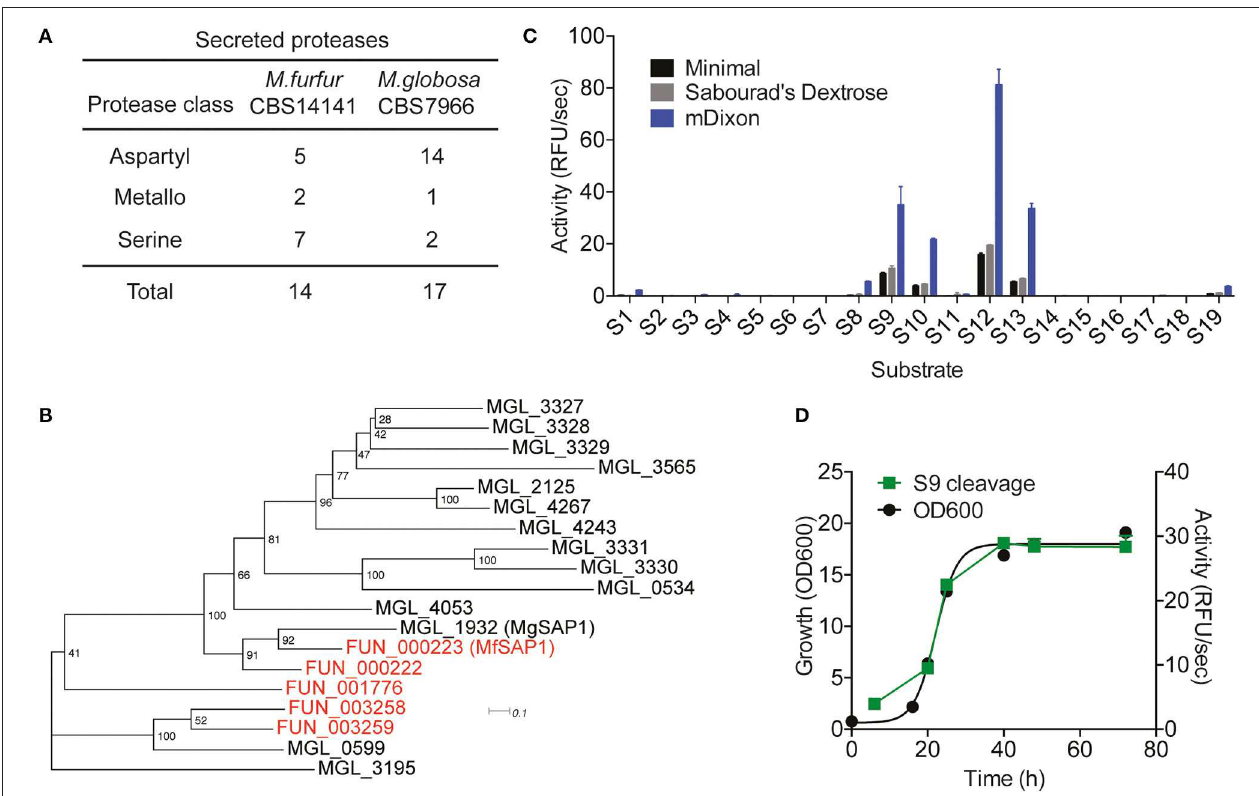
FIGURE 1 | Prediction of Malassezia furfur secreted proteases and assessment of extracellular protease activity in culture. (A) A comparison of the predicted secreted proteases in M. furfur CBS 14141 and M. globosa CBS 7966. (B) Unrooted phylogenetic tree of the predicted secretory aspartyl proteases in M. globosa (14, in black) and M. furfur (5, in red). Number at each node indicates the bootstrap value. (C) Extracellular protease activity of M. furfur cultured in 3 different media assessed using 19 internally quenched substrates. (D) Correlation of secreted protease activity using a representative substrate S9 with planktonic culture growth. Error bars represent standard deviation for n =